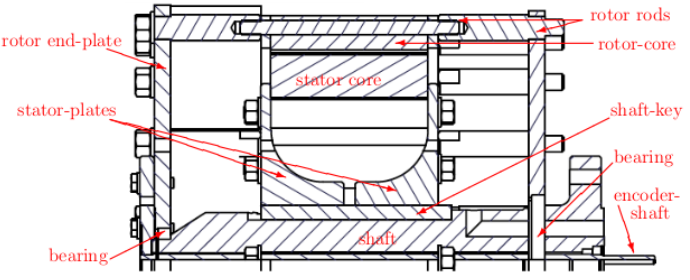
Figure 23. Longitudinal cross section of PMVM prototype structure (winding not